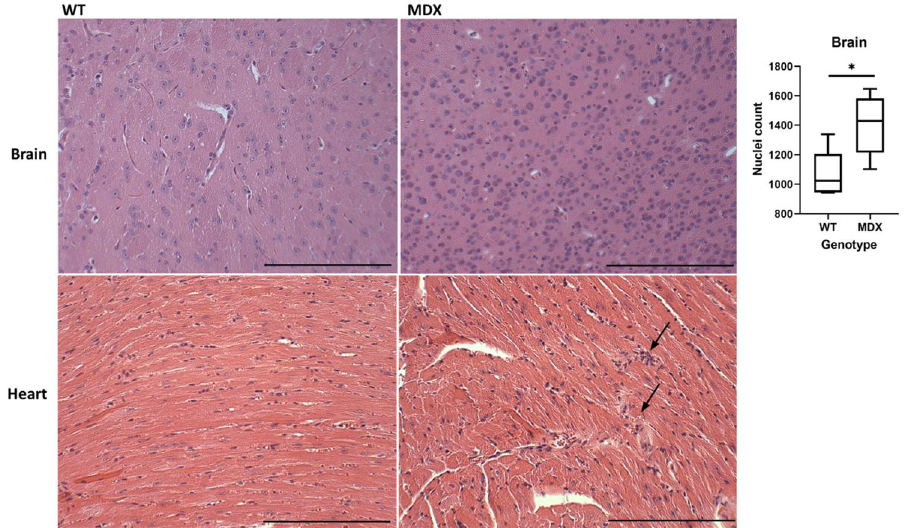
Figure A4. Representative Hematoxylin and Eosin (H&E) stained images from heart and brain tissue sections of an 8–10 week dystrophin-deficient mdx:utrn (+/−) mouse (MDX) and age-matched C57bl/10 wild-type (WT) mouse. Heart tissue obtained from MDX mouse show infiltrate (black arrows) within heart tissue and higher nuclei counts (mean (±SE)) in brain tissues. Heart image filter chosen to highlight myocardial fibers. Images scale bar = 100 µm; one biological and 3 technical replicates were used for the heart and one biological, and 6 technical replicates were used for the brain. Significant difference ( p < 0.05), indicated by *.